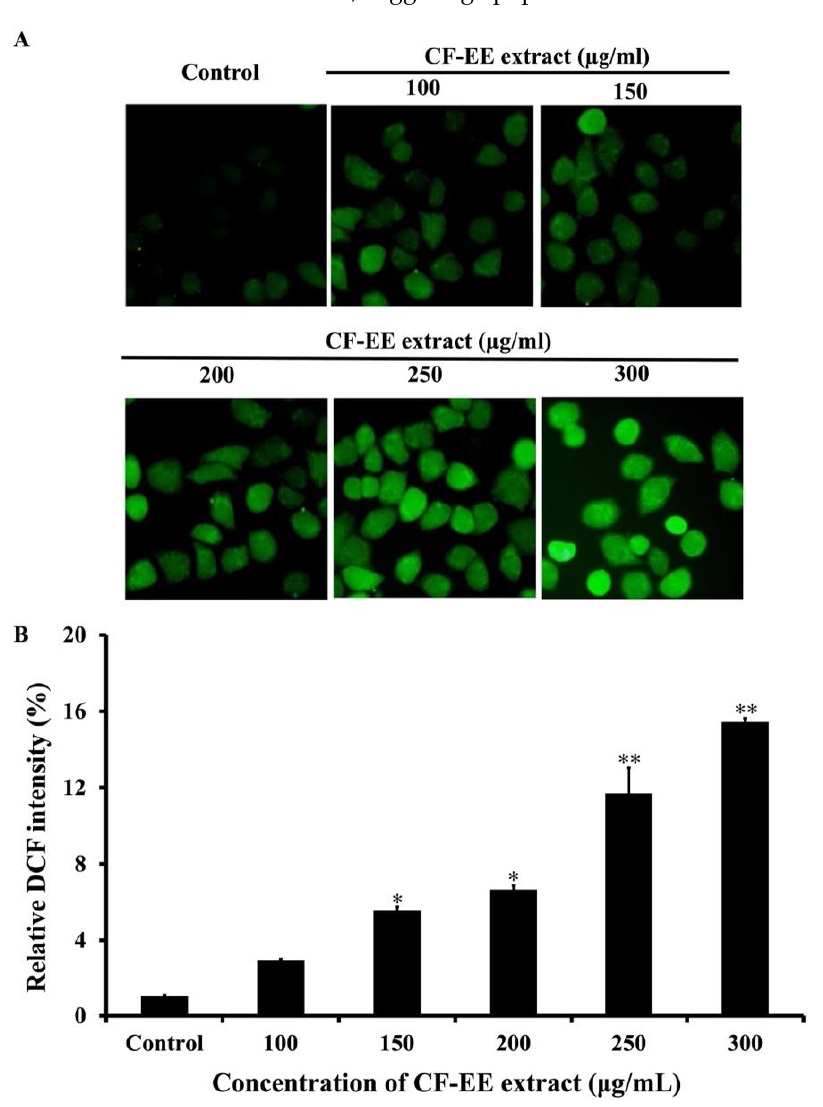
Figure 5. Effect of CF-EE extract on intracellular ROS production in HeLa cells. The cells were stained with 20 µ M of DCFH-DA and visualized by a fluorescence microscope (20 × ). ( A ) DCF-fluorescence signal (green-color) in cells, observed under a fluorescence microscope. ( B ) The average relative DCF-fluorescence intensity. * p < 0.05 and ** p < 0.01 compared to the control.